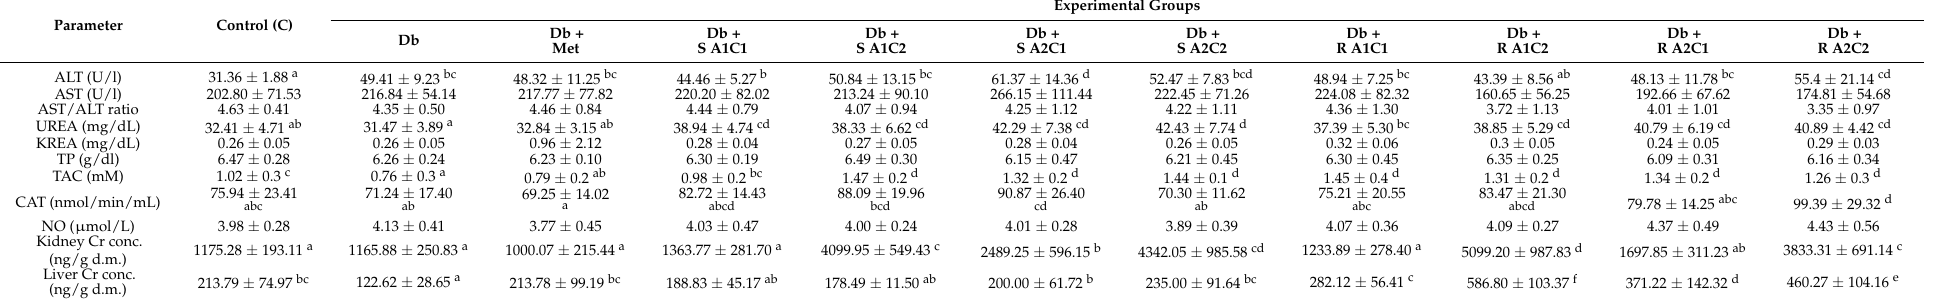
Table 4. Effects of the diet and combined SG, L-arg, and Cr(III) supplementation on other biochemical indices in